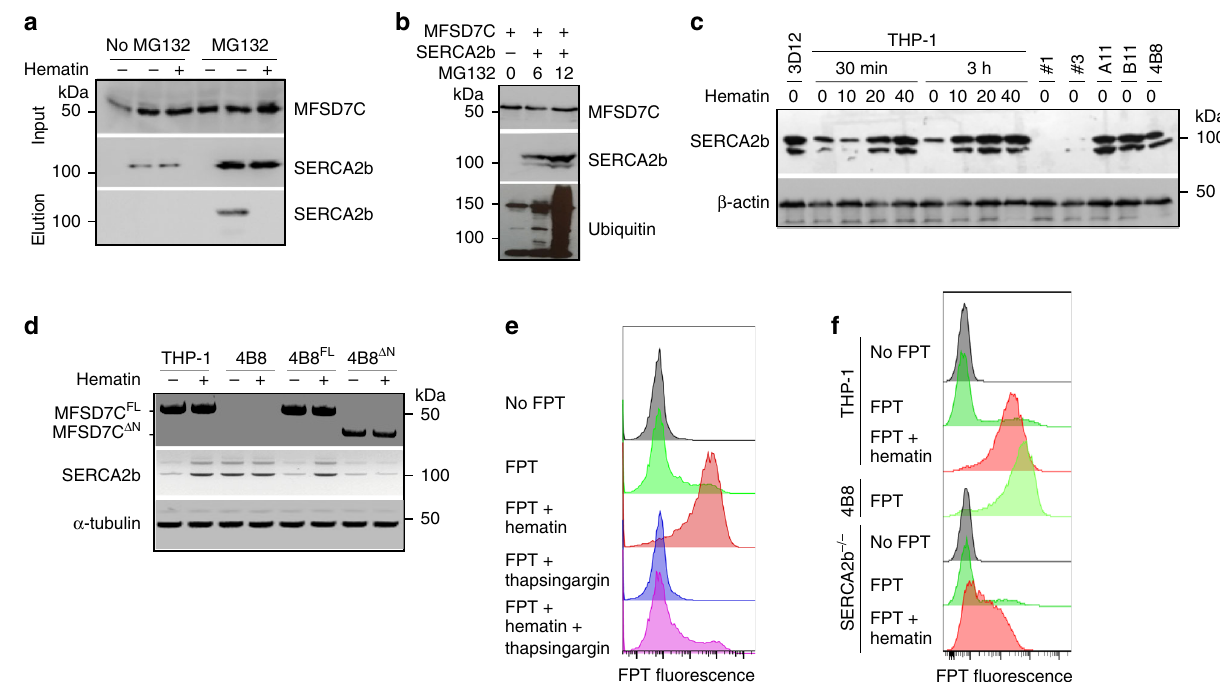
Fig. 5 MFSD7C and heme regulate thermogenesis through SERCA2b in THP-1 cells. a 293FT cells were transfected with HA-tagged murine MFSD7C and FLAG-tagged murine SERCA2b. Thirty hours later, MG132 was added into half of the cells and the other half was not treated. Another 35 h later, some cells were treated with 40 μ M heme for 1 h before lysis. Cell lysates were immunoprecipitated with anti-FLAG antibody, and eluted, followed by anti-HA immunoprecipitation and elution. Total cell lysate and elute were subjected to Western blotting and probed with anti-SERCA2b or anti-MFSD7C antibodies. Shown are representative data from one of three experiments. b 293T cells were co-transfected with HA-MFSD7C and FLAG-SERCA2b. Twenty-four hours later, cells were either not treated or treated with 10 μ M MG132 for either 6 or 12 h. The cells were lysed and subjected to FLAG pull- down and blotted with anti-MFSD7C, anti-SERCA2b and anti-ubiquitin antibodies. Shown are representative data from one of three experiments. c SERCA2b protein levels in parental THP-1 cells, 7CKO cells (3D12, A11, B11, and 4B8) or SERCA2b − / − (#1 and #3) cells. Parental THP-1 cells were either not treated or treated with heme before lysis. Shown are representative data from one of four experiments. d THP-1, 4B8, 4B8 FL , and 4B8 Δ N cells were either not treated or treated with 40 μ M heme for 1 h, lysed and subjected to Western blotting with anti-MFSD7C (top), anti-SERCA2b (middle), and anti- ® -tubulin (bottom). Shown are representative data from one of two experiments. e THP-1 cells were incubated with FPT for 6 h, washed, treated with or without 4 μ M thapsigargin for 2 h. Cells were washed and treated with 40 μ M heme for 1 h before fl ow cytometry. Representative FPT histograms from one of three experiments are shown. f Parental and Serca2b − / − THP-1 cells were incubated with FPT for 6 h, washed and treated with or without 40 μ M heme for 1 h, followed by fl ow cytometry. Shown are representative FPT histograms from one of three experiments.